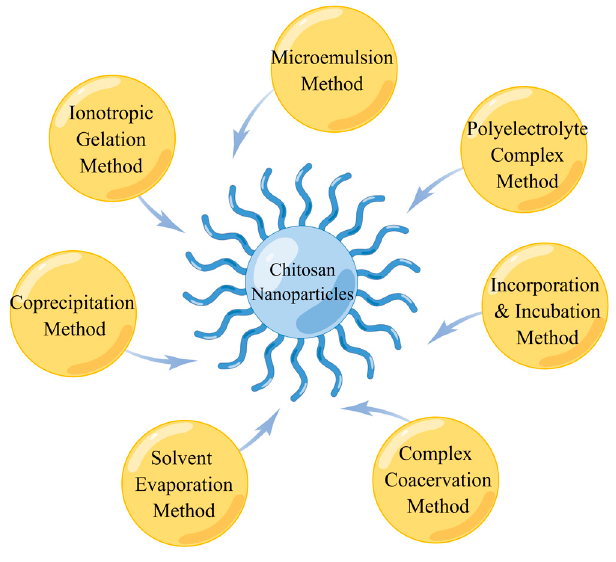
Figure 2. Methods of preparation of chitosan nanoparticles.